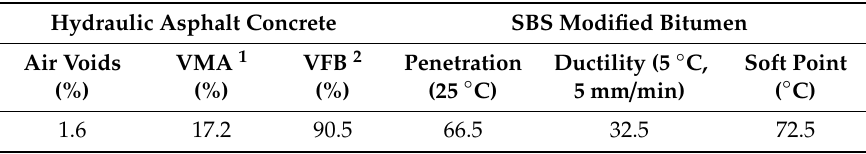
Table 2. Volumetric properties of hydraulic asphalt concrete and bitumen.